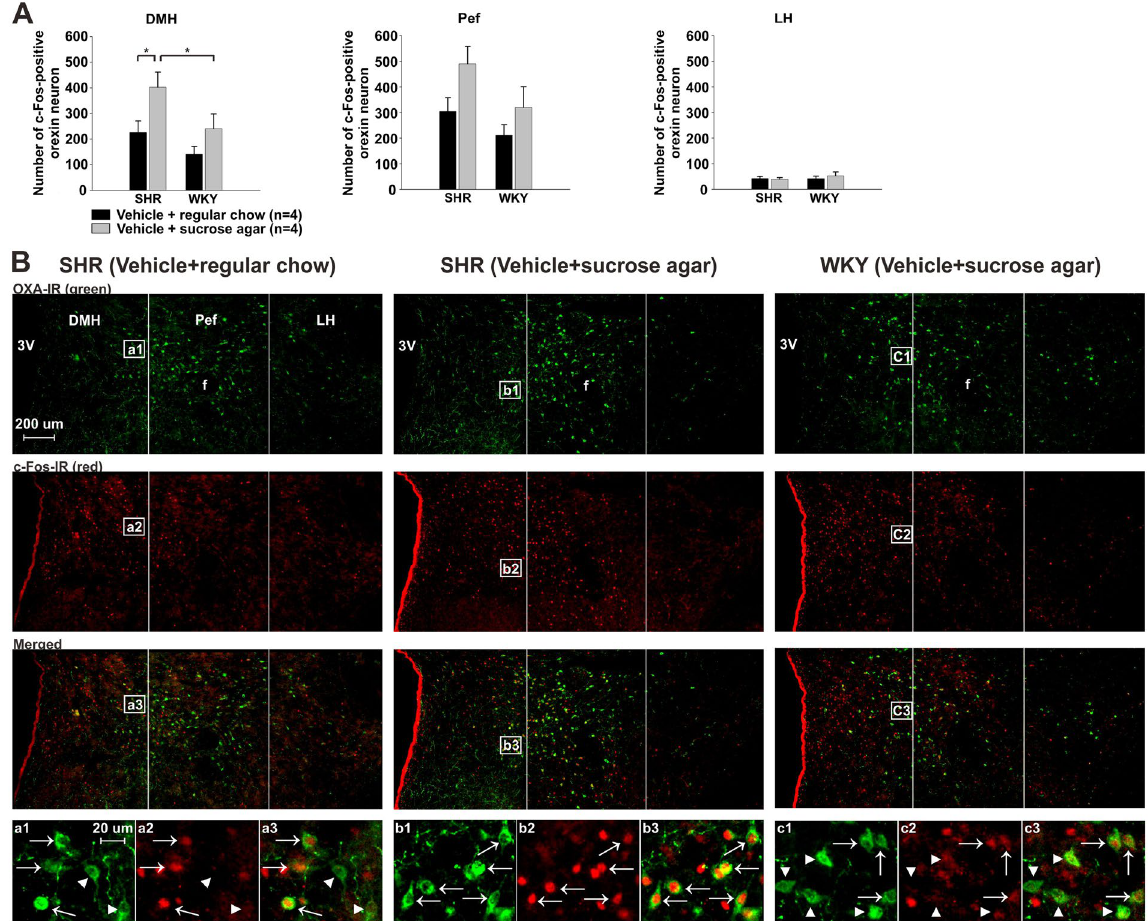
Figure 6. Comparisons of c-Fos expressions in orexin neurons following food consumption in spontaneously hypertensive rats (SHR) and Wistar-Kyoto rats (WKY). Panel A presents the numbers of double-labeled cells in three hypothalamic sub-regions in SHR and WKY of different treatment groups as indicated. Values are the mean ± SEM. A star “ * ” indicates a significant difference between the indicated groups, as determined by a one- factor ANOVA followed by Duncan’s multiple-range test. Panel B demonstrates fluorescent photomicrographs of the immunoreactivity (IR) of orexin A (OXA) (top row, green), and c-Fos (2nd row, red) in coronal hypothalamic sections (at approximately − 3.1 mm to the bregma) from SHR and WKY that had received the indicated treatments. Merged images of OXA- and c-Fos-IR are shown on 3rd row. Bottom row shows images of square regions indicated in three upper rows at higher magnification. The three hypothalamic sub-regions, the dorsomedial hypothalamus (DMH), perifornical hypothalamus (PeF) and lateral hypothalamic area (LH), are divided by two white vertical lines. Arrowheads indicate neurons single-labeled with OXA-IR, and arrows indicate cells double-labeled with OXA- and c-Fos-IR. Abbreviations: 3 V, third ventricle; f, fornix. Scale bars indicate 200 μ m in three upper rows and 20 μ m in high magnification images (bottom